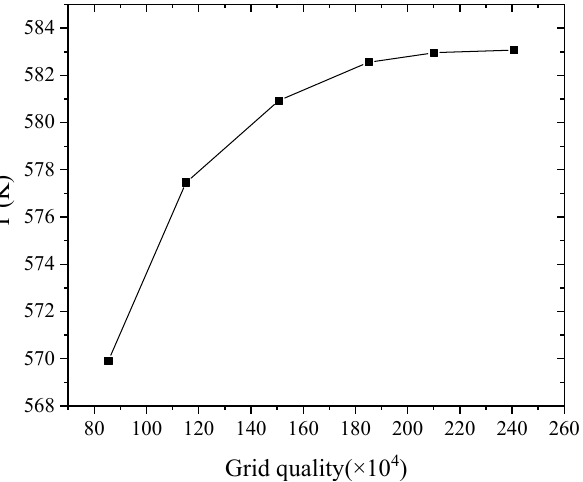
Figure 4. Variation curve of outlet average temperature with different number of grids.